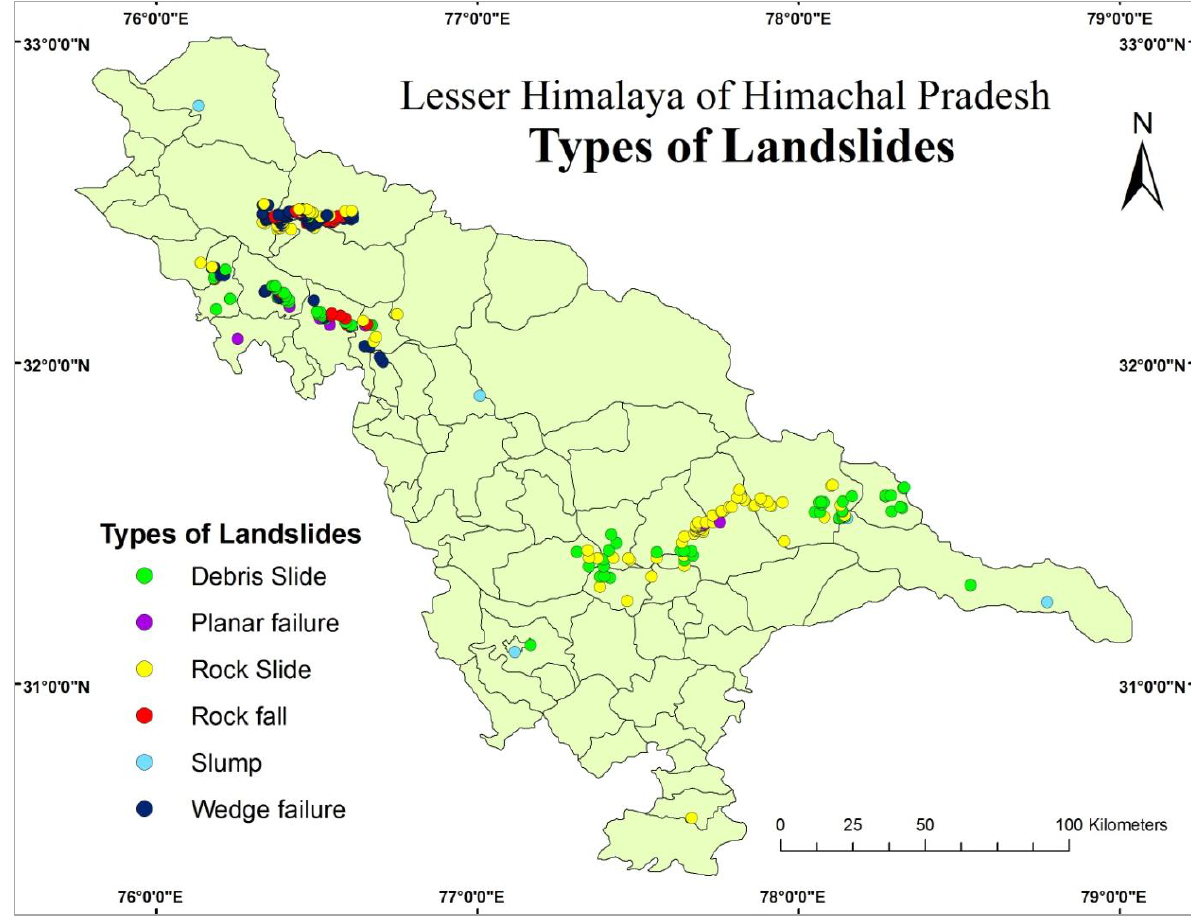
Fig. 3. Types of landslides (compiled by Authors based on Geological Survey of